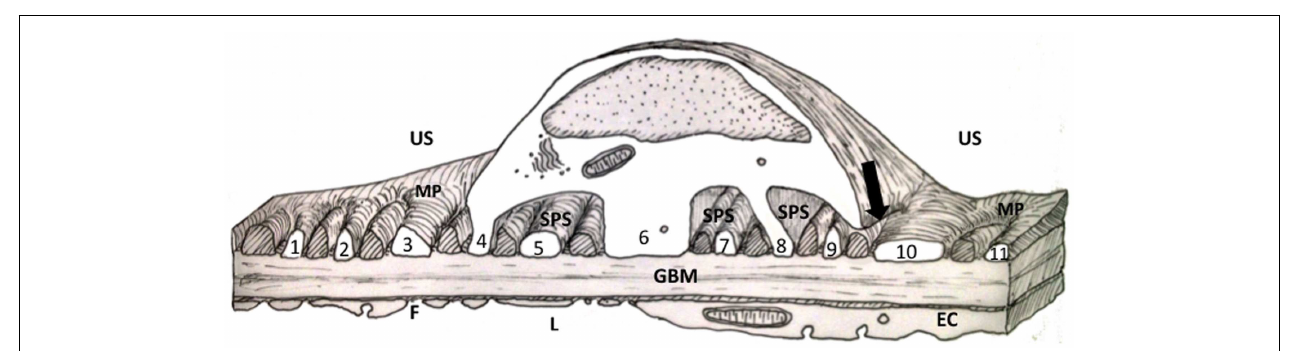
the MP of a podocyte neighbor (for further discussion of this figure see the text). EC, endothelial cell; F, fenestration; GBM, glomerular basement